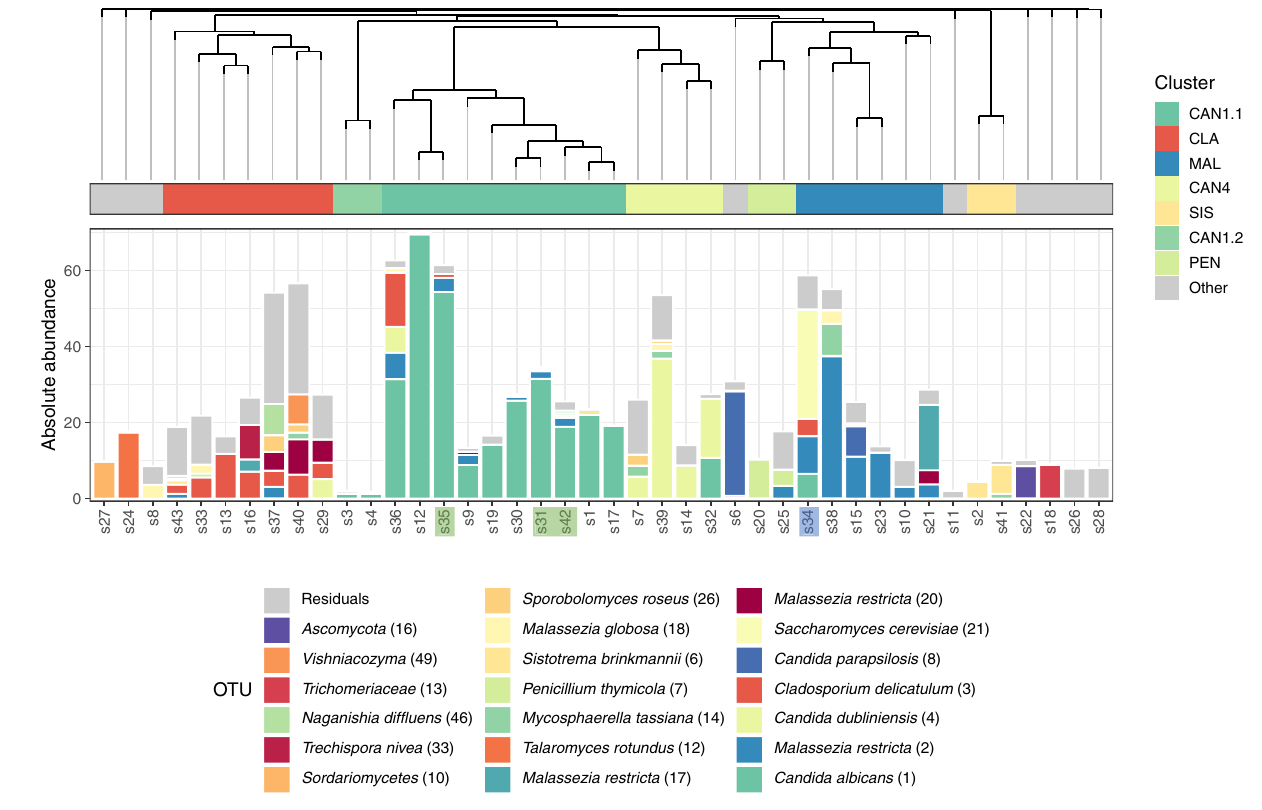
Figure 2. Respiratory fungal communities in COVID19 patients. Dendrogram visualizing a hierarchical clustering of samples. Stacked bar charts show the absolute abundance of the 20 highest-ranked OTUs and of residual bacteria. On the basis of clustering indices, an optimal number of 16 clusters was identified, 7 of which comprised more than one study samples. Classifier taxa for these seven clusters were: Candida albicans (CAN), Cladosporium (CLA), Malassezia (MAL), Candida dubliniensis (CAN4), Sistotrema (SIS) and Penicillium (PEN). Gray mark individuals not included in any of these eight clusters. Candida albicans (1) dominated two separate clusters, one comprised 10 samples, termed CAN1.1 and the second comprised two samples, termed CAN1.2- Cluster. Cluster dominated by Candida dubliniensis (4) is termed CAN4. All the samples are tracheal aspirates except for s31, s35 and s42 that are sputum (highlighted in green) and s34 that is bronchoalveolar lavage (highlighted in